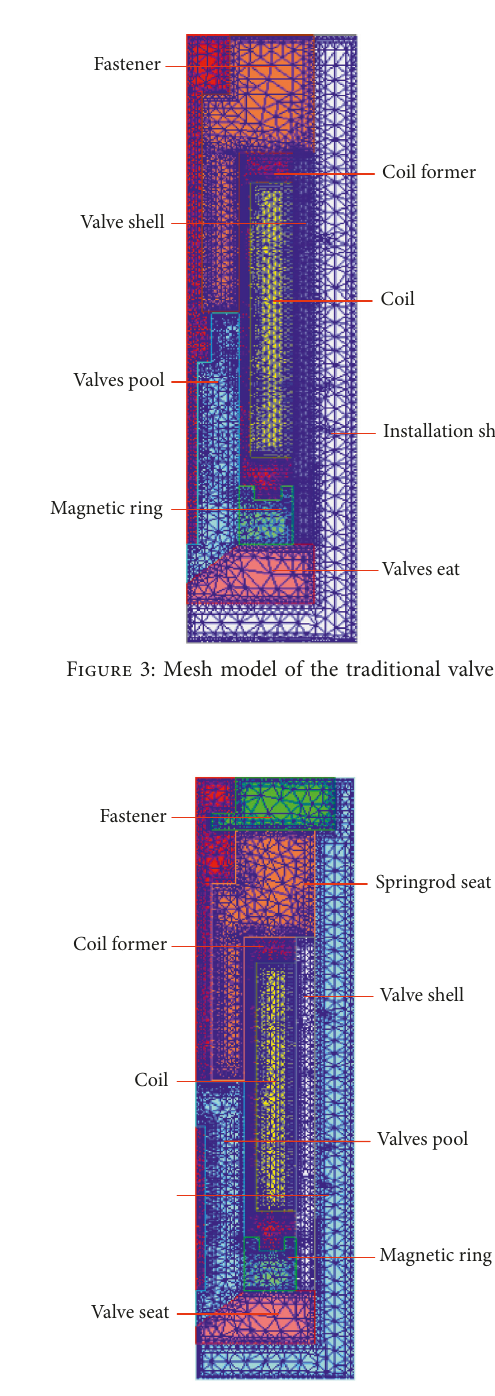
Figure 4: Mesh model of the novel